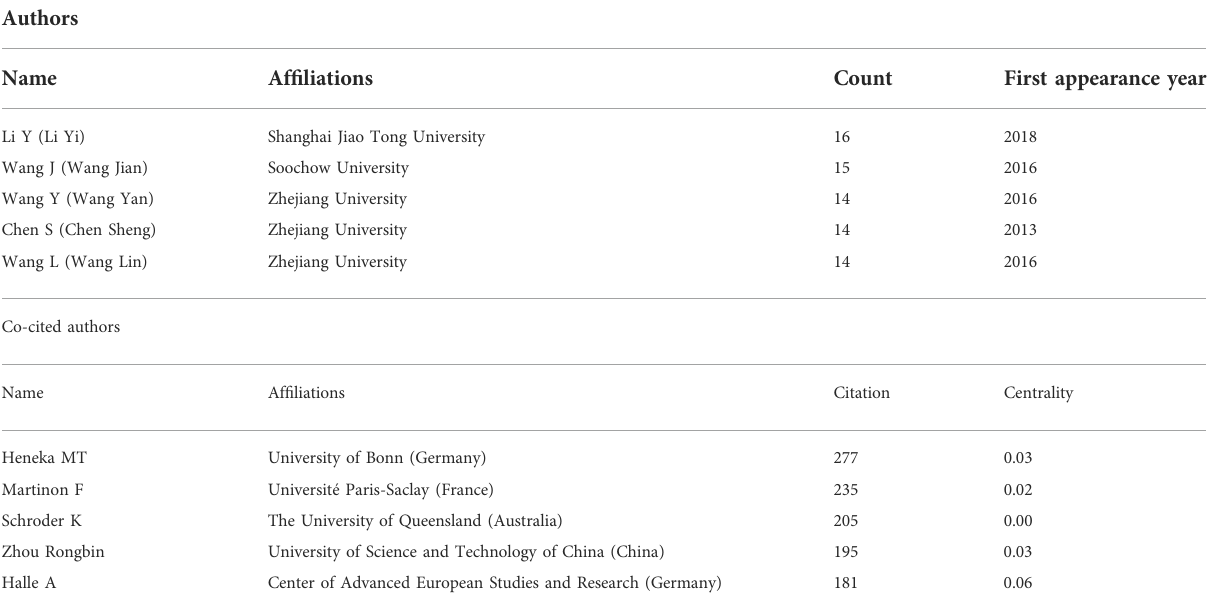
TABLE 3 Top fi ve authors and co-cited authors (2010 –